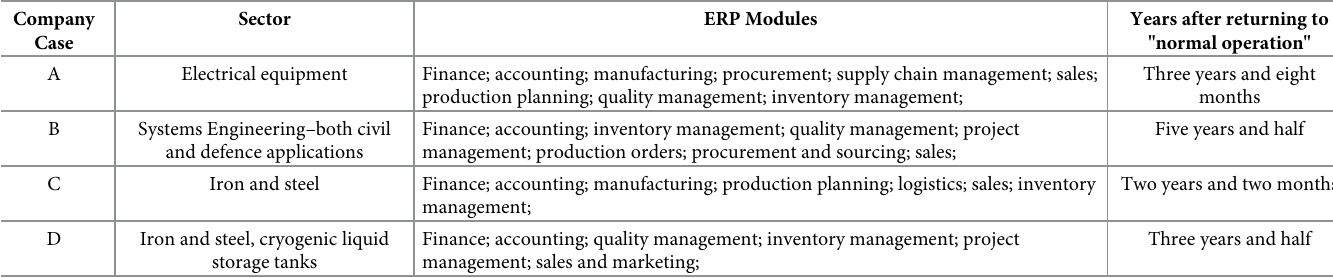
Table 2. Characteristics of the selected firms.